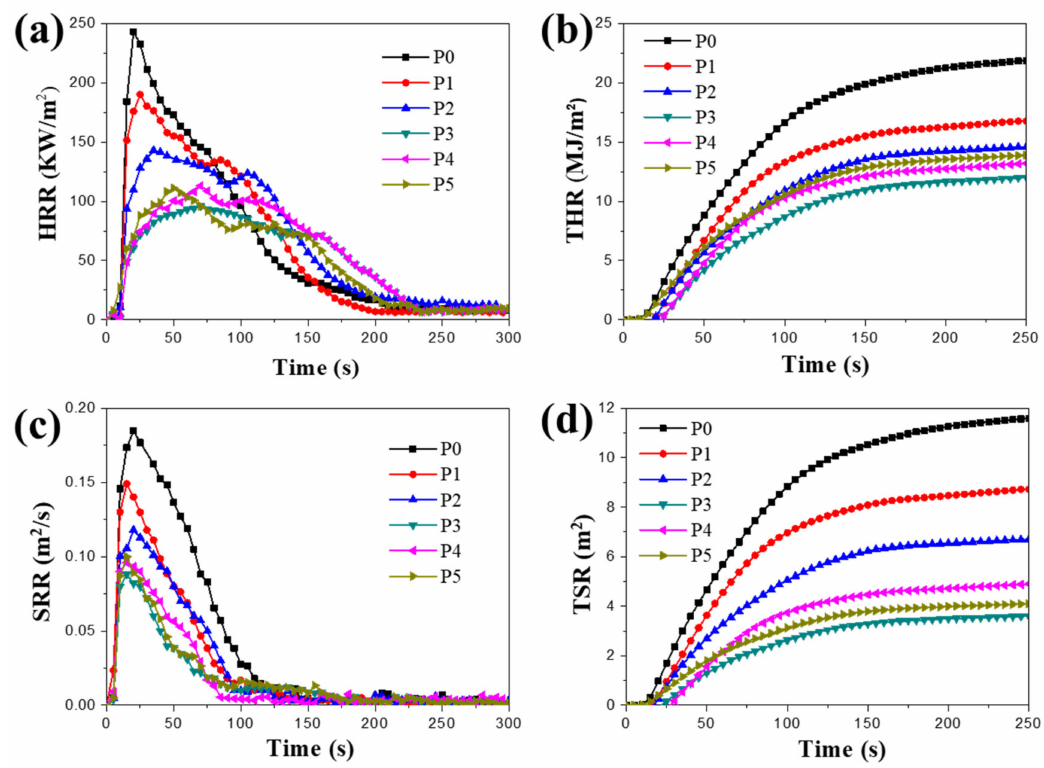
Figure 8. The curves of the heat release rate ( a ), the total heat release ( b ), smoke release rate ( c ) and the total smoke release ( d ) of the flame-retardant RPUF modified by IL EG / DPES.